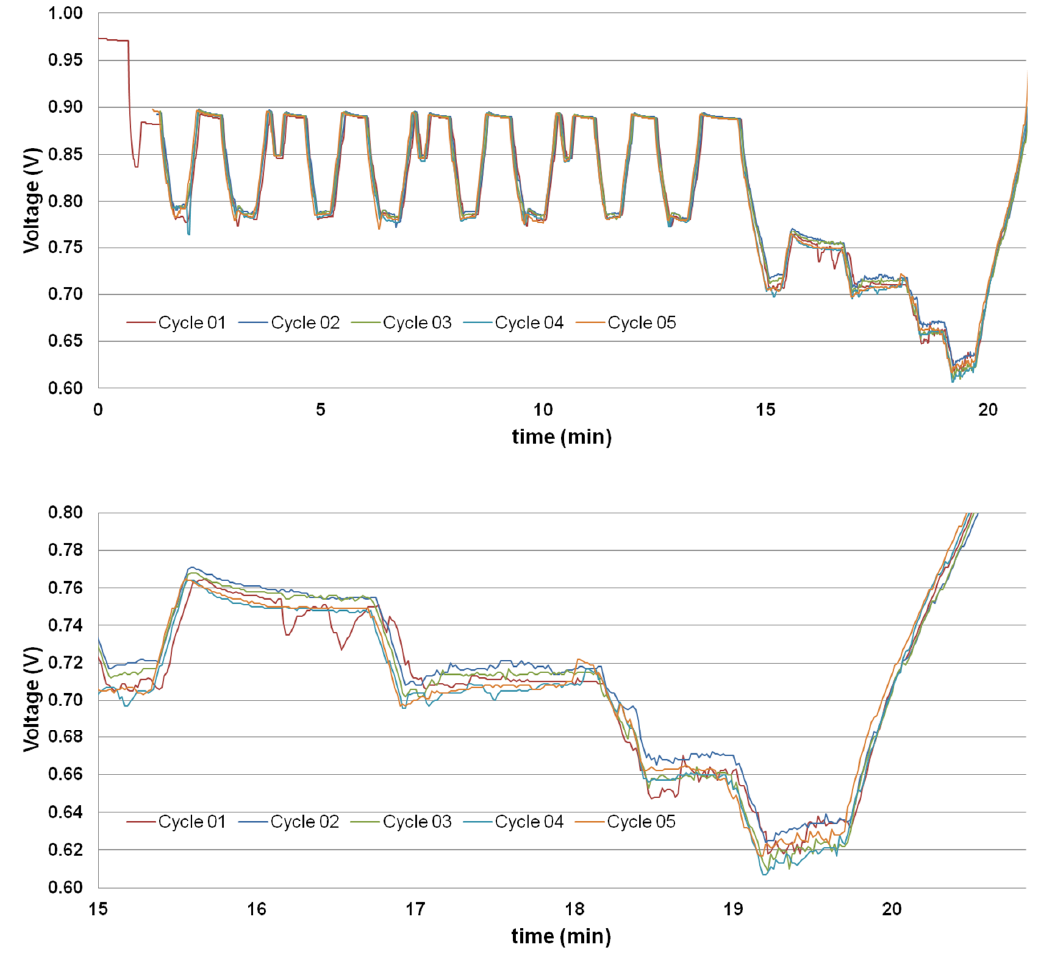
Figure 8. Superposition of the evolution of the cell voltage corresponding to the five cycles during the load cycle test. ( Top ) complete load cycles; ( Bottom ) high load (15 min to 21 min) close-up.